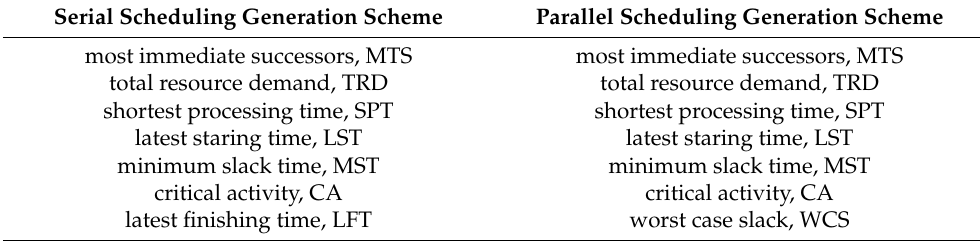
Table 2. Schedule generation schemes and corresponding priority rules.